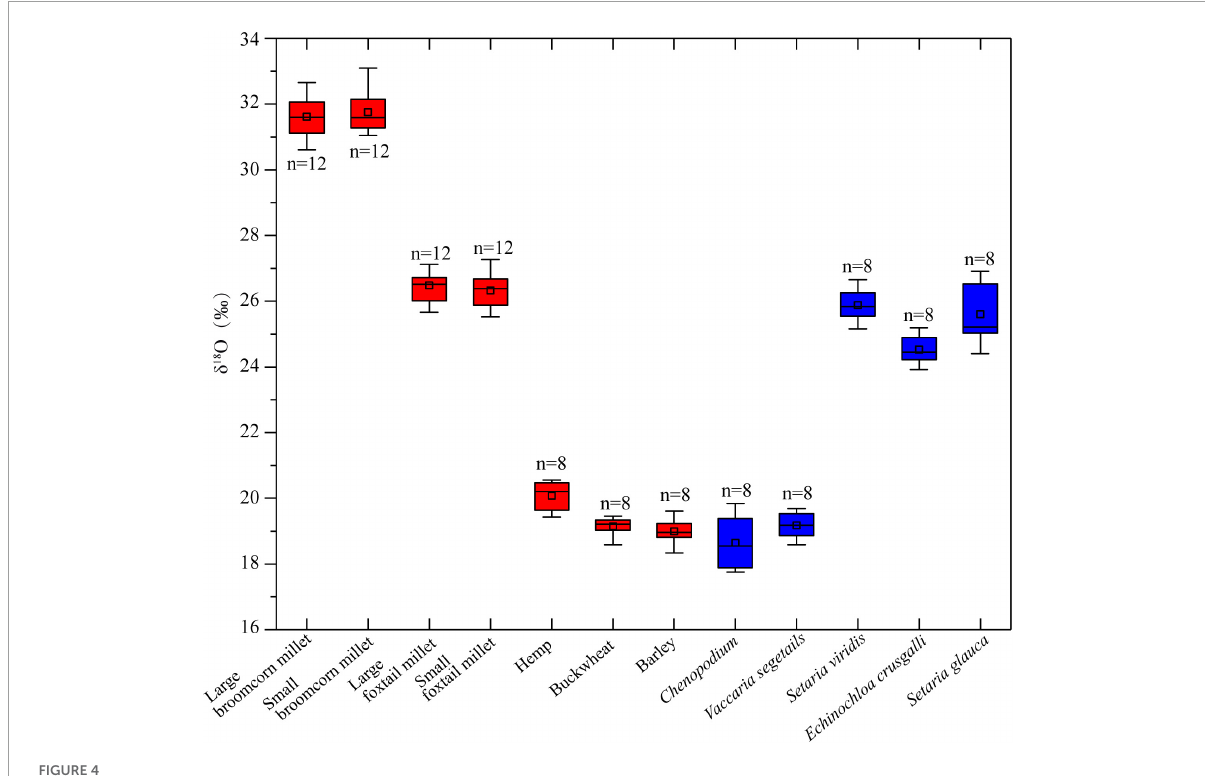
FIGURE4 The box plot of oxygen isotopic values for plant remains from the Chashancun cemet.